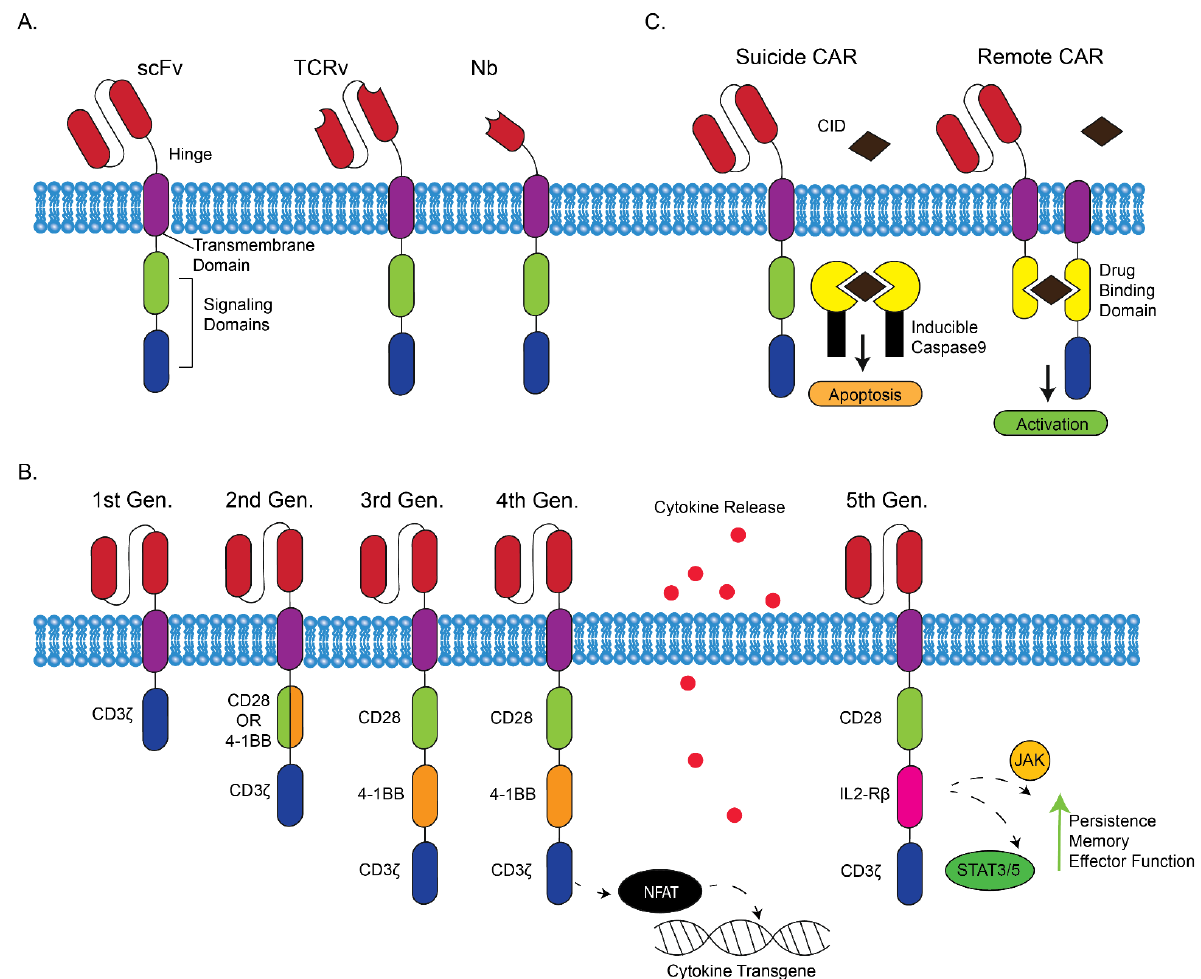
Figure 1. Overview of CAR constructs, the five CAR generations, and regulatory options. ( A ) Various CAR constructs are shown with scFv, TCR variable region (TCRv), and nanobody (Nb) extracellular domains. ( B ) CAR generation constructs are shown with the various changes to internal signaling domains. First generation CARs only include one intracellular signaling domain (CD3 ζ